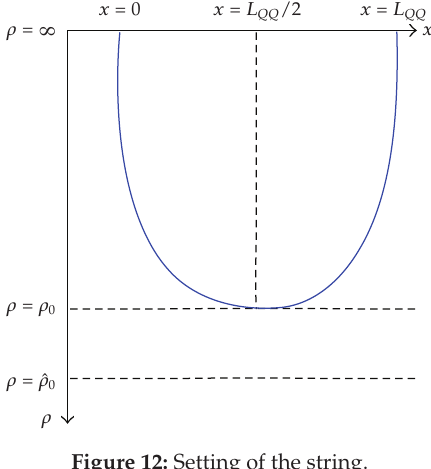
Figure 12: Setting of the